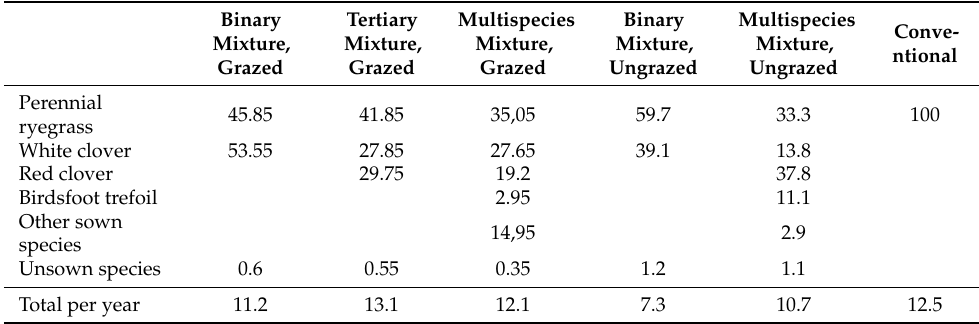
Table A5. Results of the yield measurements, dry matter in tons per year and the percentages of the total dry matter per plant